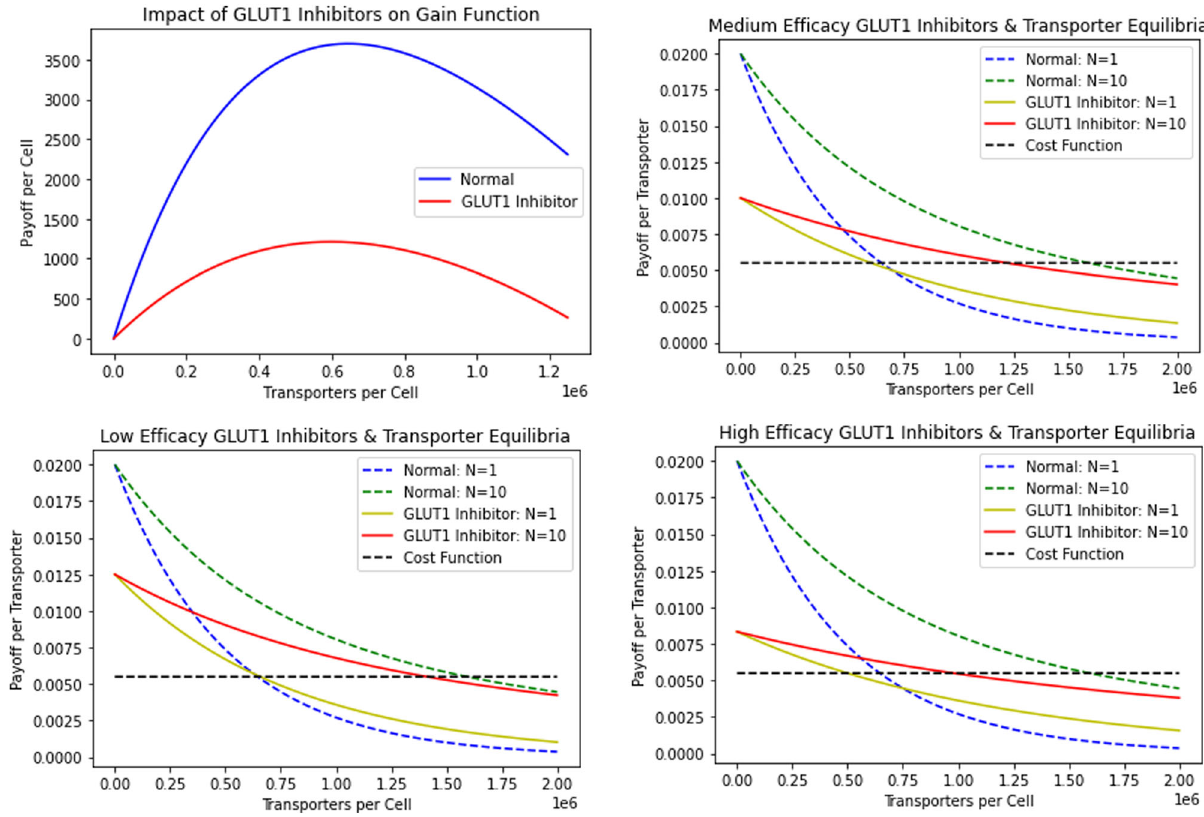
Fig. 4 Impact of GLUT1 inhibitor treatment. A lower payoff curve per cell results from treatment. The ESS number of transporters per cell is similar to and lower under GLUT1 treatment than under no treatment for N = 1 and N = 10, respectively.